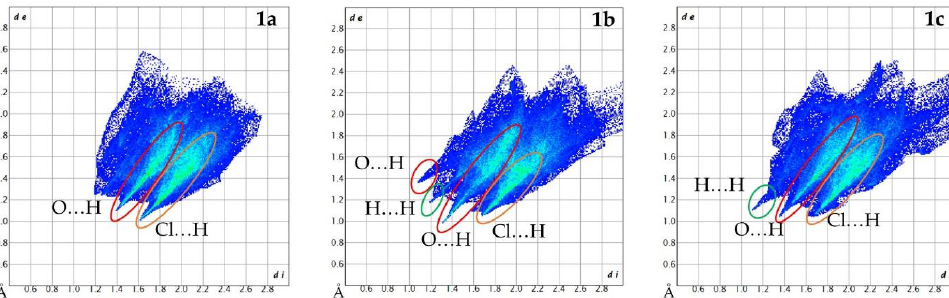
Figure 8. 2D fingerprint plots ( d i /d e ) of 1a (left), 1b (middle), and 1c (right) showing the types of shortest interactions for each Hirshfeld surface.